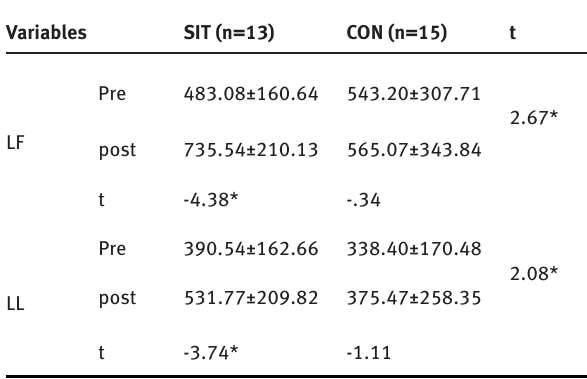
Table 2: Comparison of pre and post muscle activity in the SIT and CON (mean±SD)